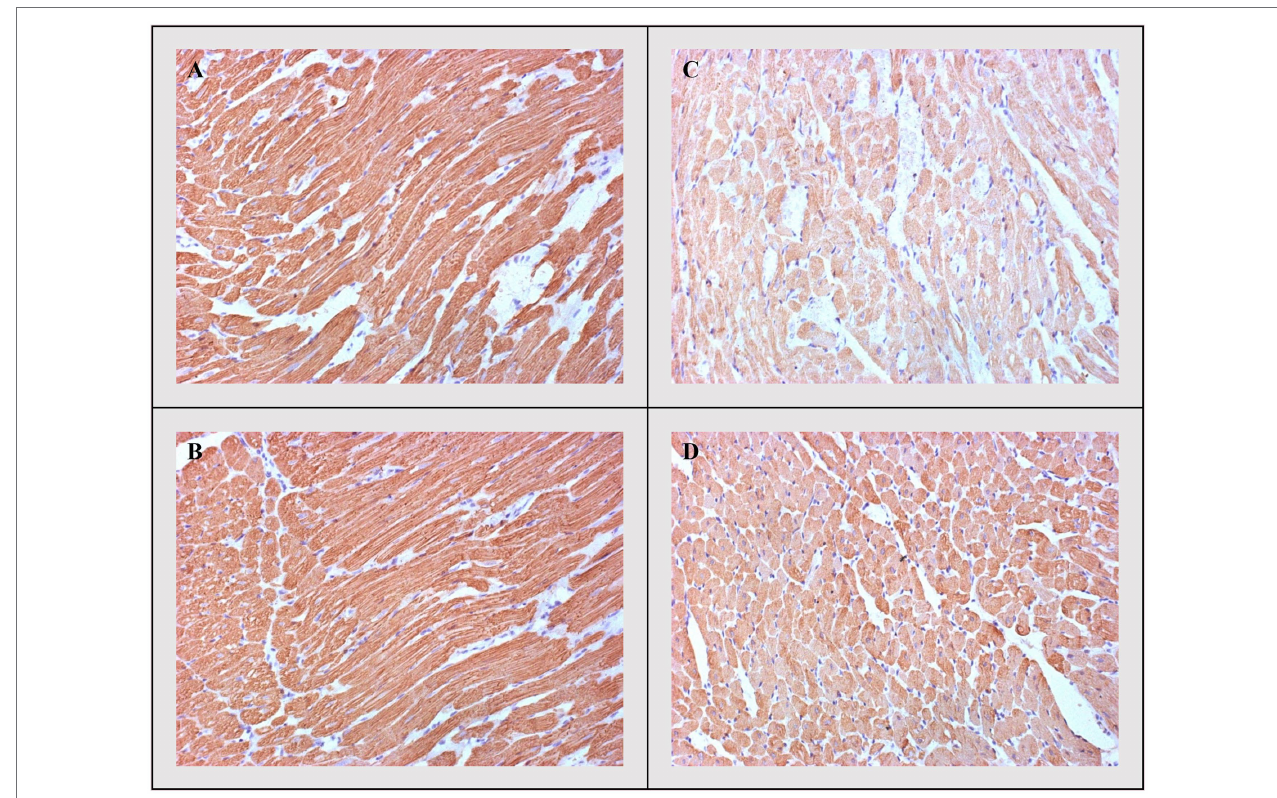
FIGURE 8 | cTnT-immunostaining. (A) CTRL, (B) THIA, (C) DOX, and (D) DOX + THIA. Original magnification 20 ×